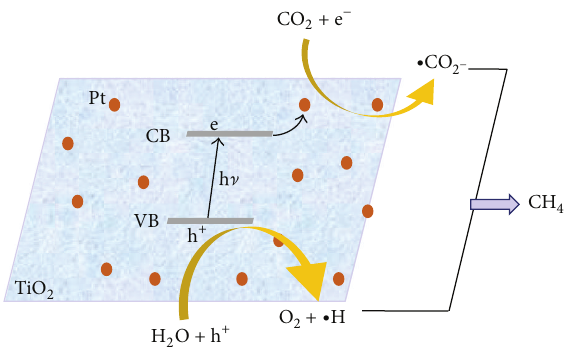
Figure 5: Photoreduction mechanism of CO 2 to methane on Pt- loaded TiO 2 nanosheet porous